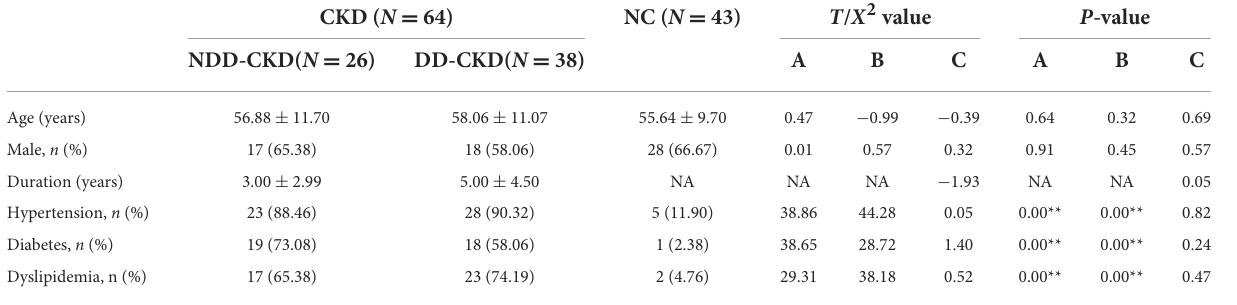
TABLE 1 Demographic of the CKD and NC groups.